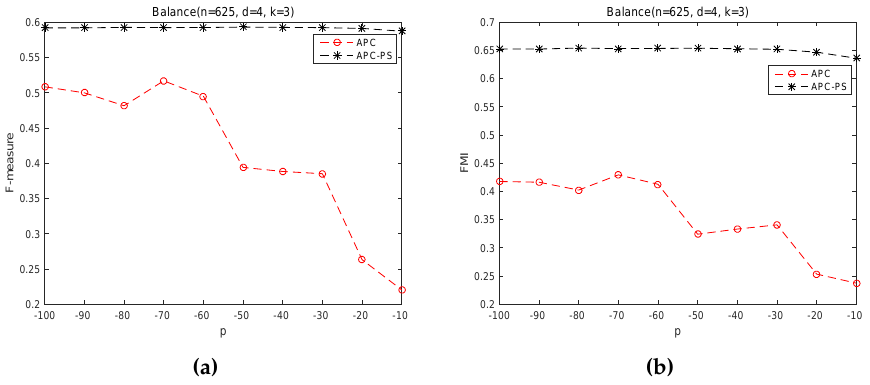
Figure 3. APC and APC-PS on Balance scale dataset under different values of p . ( a ) F-measure; ( b )